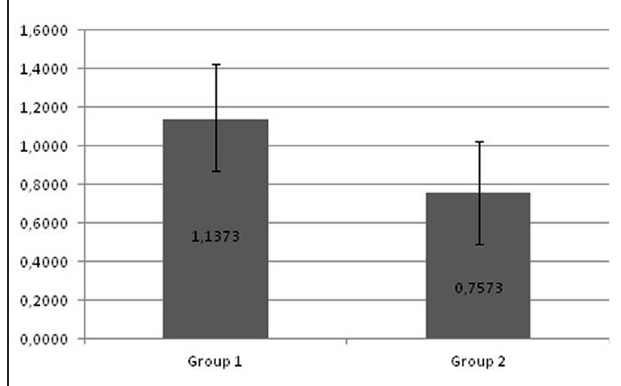
Fig. 3. Mean values and standard deviations for the distances between the root canal center and the furcation area for Group 1 (before Gates-Glidden preparation) and for Group 2 (after Gattes-Glidden preparation)